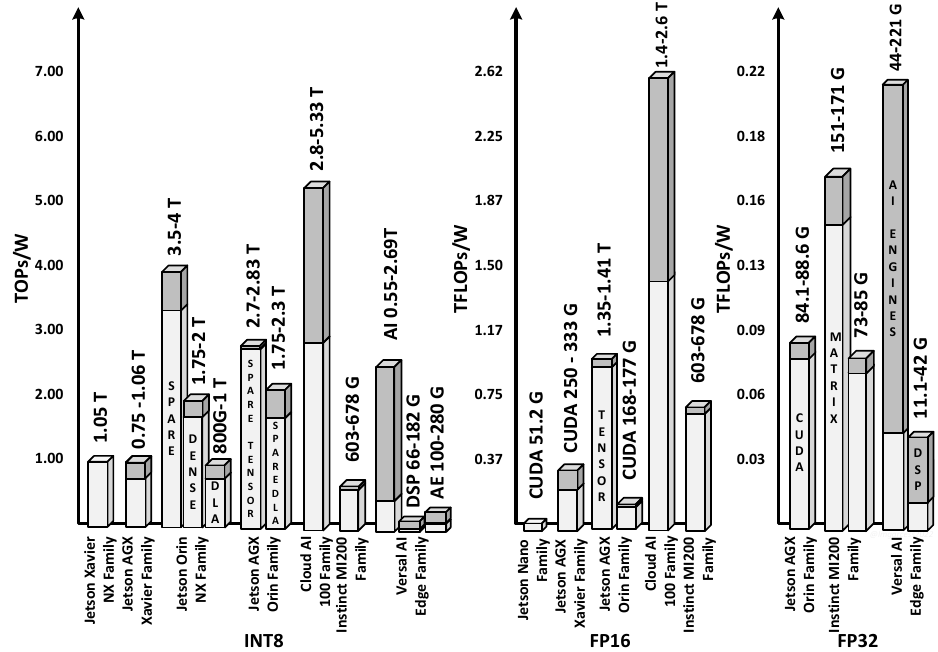
Figure 11. Performance related to the power consumption of the most remarkable families in byte operations (INT8), half-precision floating point operations (FP16), and simple-precision floating point operations